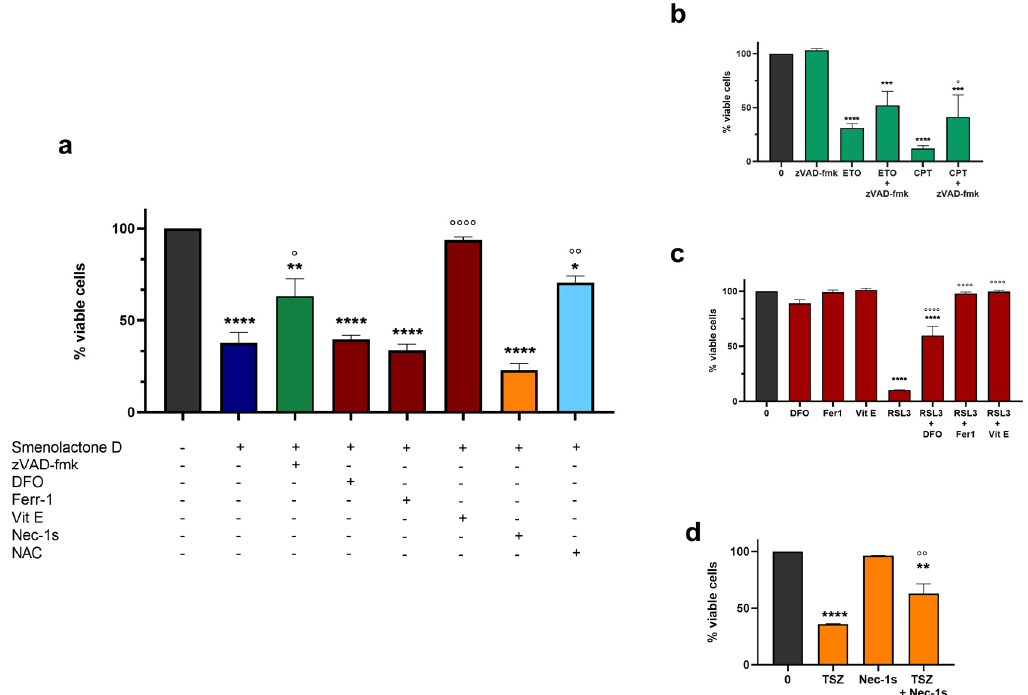
Figure 6. Smenolactone D triggers apoptosis and ferroptosis. ( a ) Percentage (%) of viable cells fol- lowing 1 h pre-treatment with different pharmacological inhibitors and subsequent 48 h treatment